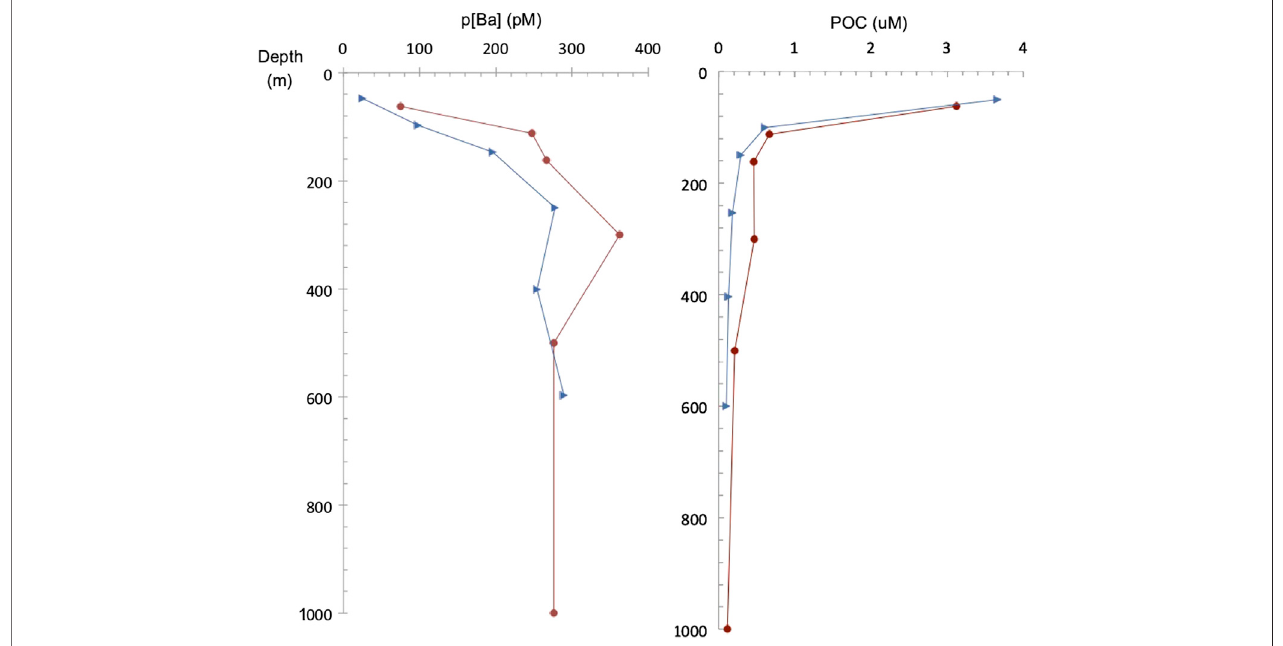
Frontiers in Earth Science |